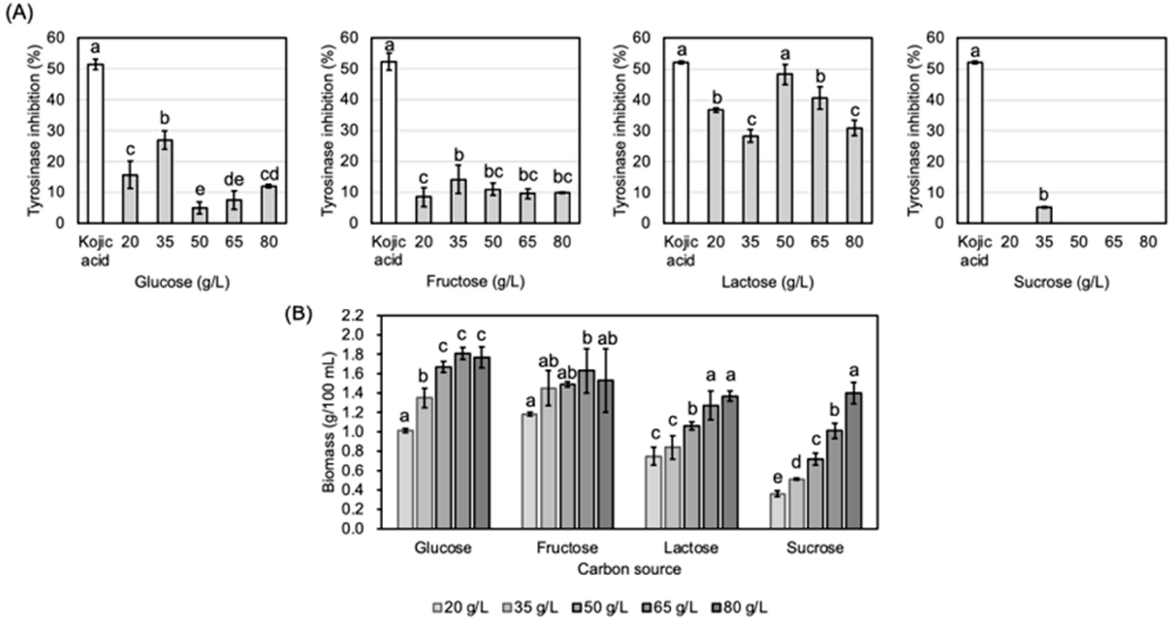
Figure 2. Culture medium supplied with di ff erent carbon sources for Ganoderma formosanum submerged fermentation. ( A ) Tyrosinase inhibition activity of G. formosanum extracts (GFE; 1 mg/mL) obtained from medium containing glucose, fructose, lactose, and sucrose (20–80 g/L). Kojic acid (0.25 mg/mL) was used as the positive control. ( B ) Biomass of GF-EPS obtained from di ff erent carbon sources. Means with di ff erent le tt ers indicate that they are signi fi cantly di ff erent ( p < 0.05).